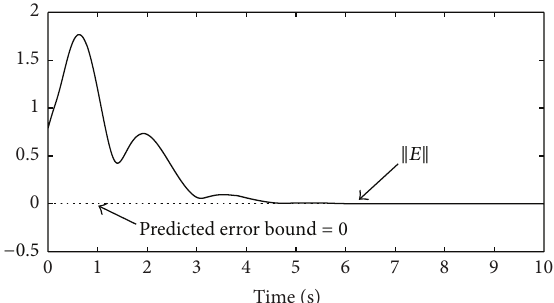
Figure 7: The error bound with matched perturbations.